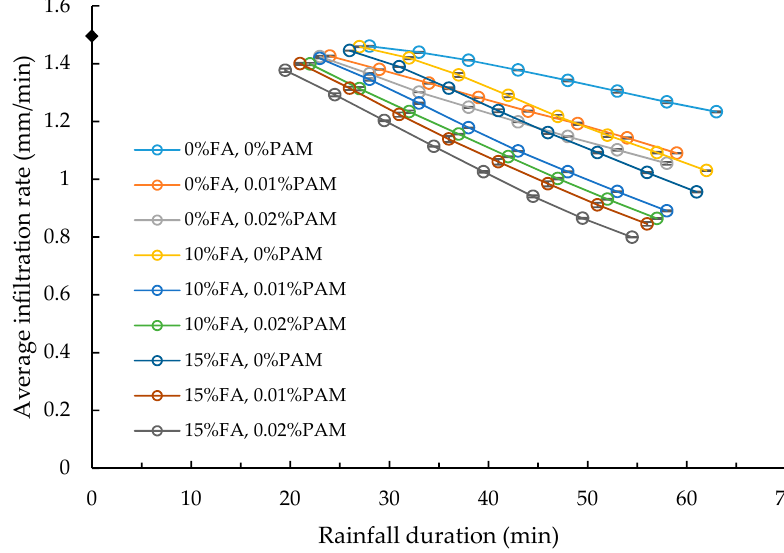
Figure 4. Changes in average infiltration rate with rainfall duration for different treatments. The error bars represent one standard deviation ( n = 3). The initial infiltration rate (at the time of rainfall began) in all treatments was assumed to be equal to the rainfall intensity, i.e., 1.5 mm / min, shown as black diamond